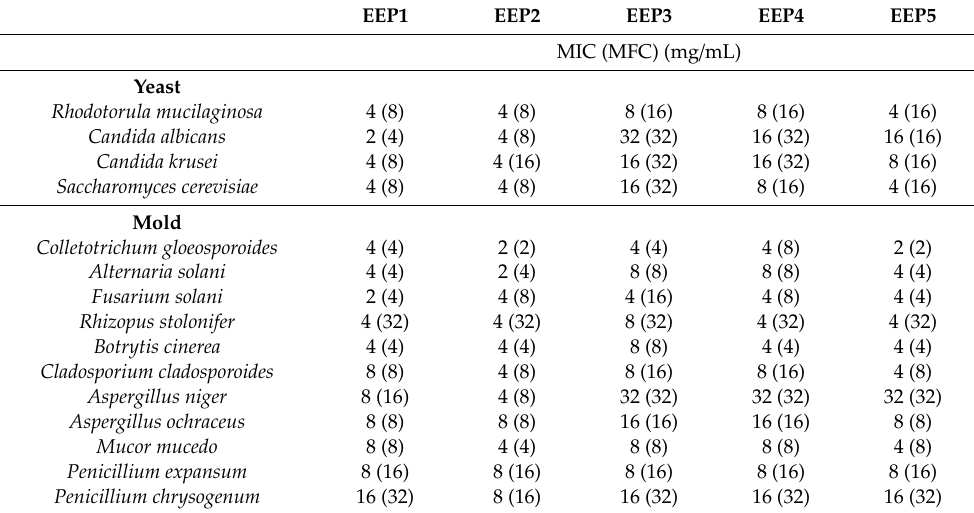
Table 6. Antifungal activity of ethanol extracts of